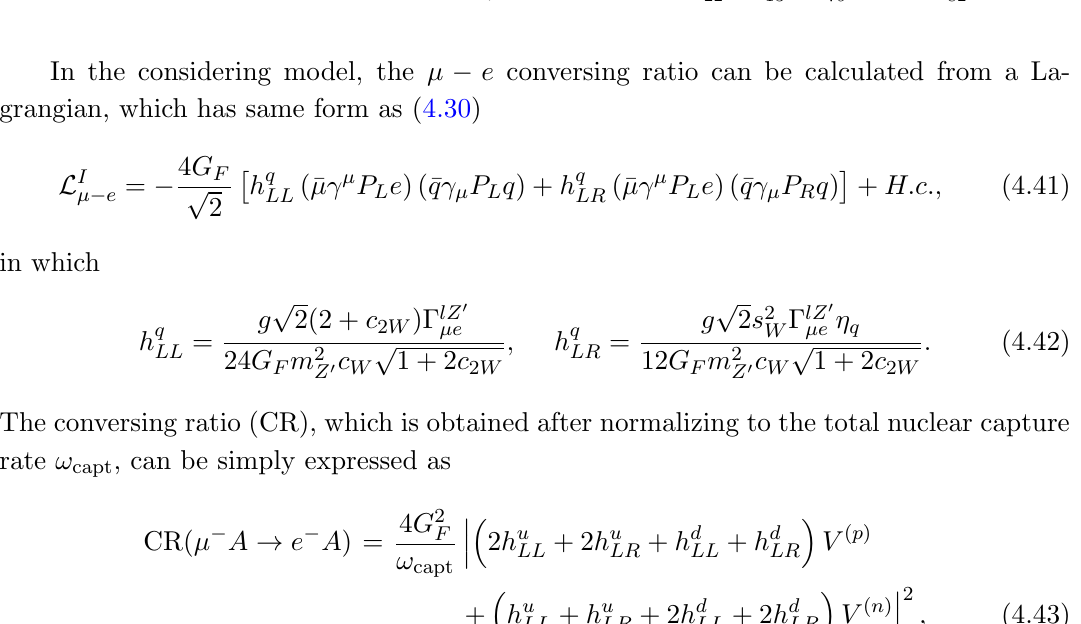
Table 3 . Nuclear parameters related to (cid:22) (cid:0) e conversion in 48